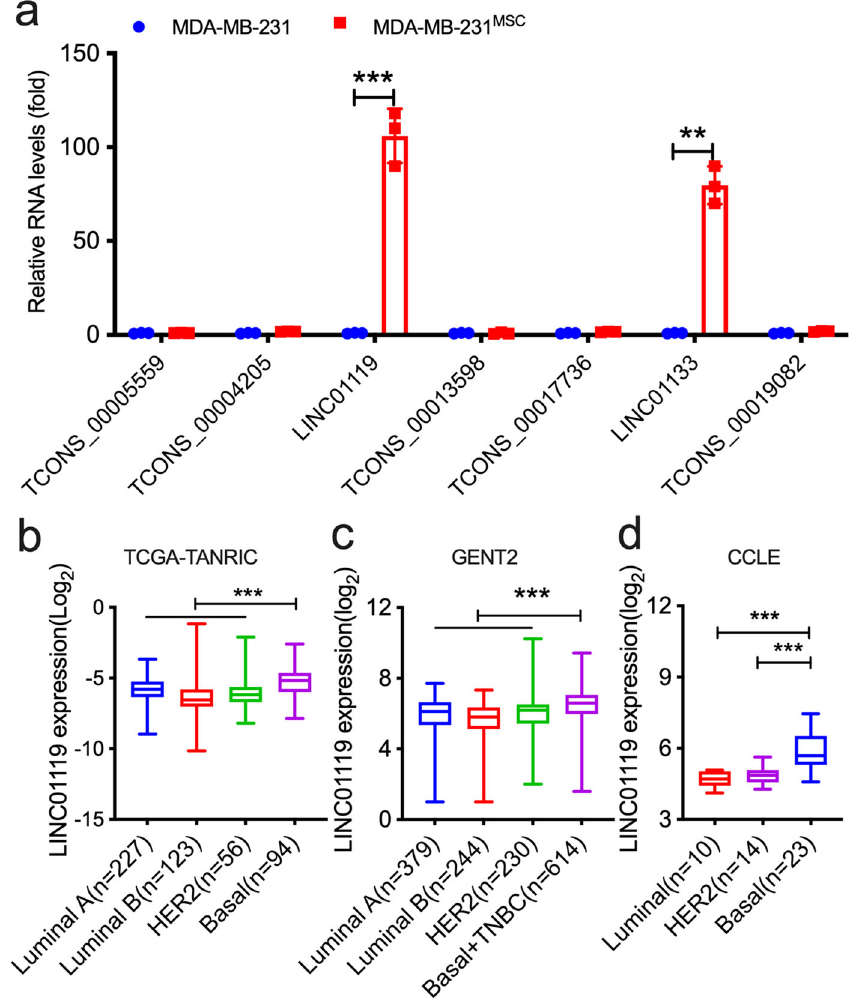
Fig. 1 MSCs upregulate LINC01119 in admixed breast cancer cells. a qRTPCR measurements (meanâ € ‰ ±â € ‰ SD of n â € ‰ = â € ‰ 3) of indicated lncRNAs in sorted MDA-MB-231 cells recovered by FACS from 72-hr co-cultures with BM-MSCs (MDA-MB-231 MSC ). Sorted MDA-MB- 231 cells cultured alone served as controls. b – d LINC01119 level (Log 2 ) in TCGA data (from TANRIC database) analyzed by signi fi cance analysis of microarrays (SAMs) ( b ), in clinical breast cancer subtypes from GENT2 database ( c ), and in cancer cell lines representing different breast cancer subtypes in CCLE ( d ). Box-and-whisker plots represent the median (centerline) and inter-quartile range (IQR; box). The whiskers extend up to 1.5 times the IQR from the box to the smallest and largest